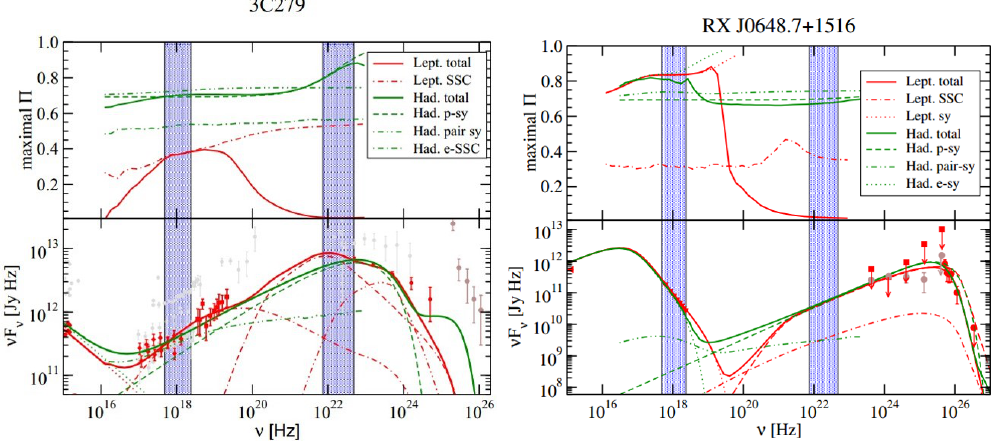
Figure 1. UV through γ -ray SEDs (lower panels) and the corresponding maximum degree of polarization (upper panels) for the two blazars 3C279 ( left ) and RX J0648.7+1516 ( right ). Leptonic model fits are plotted in red, hadronic models in green. Different line styles indicate individual radiation components, as labeled in the legend. Shaded areas indicate the 2–10 keV X-ray range and the 30–200 MeV range. The polarization degree calculation assumes a perfectly ordered magnetic